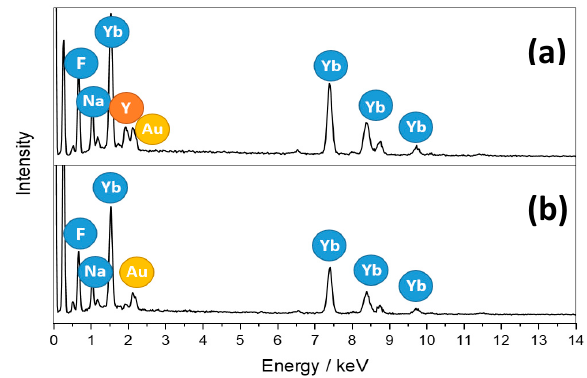
Figure 3. The EDX spectra of ( a ) the core–shell NaYb 0.99 F 4 :Tm 0.01 @NaYF 4 , and ( b ) core NaYb 0.99 F 4 :Tm 0.01 particles.